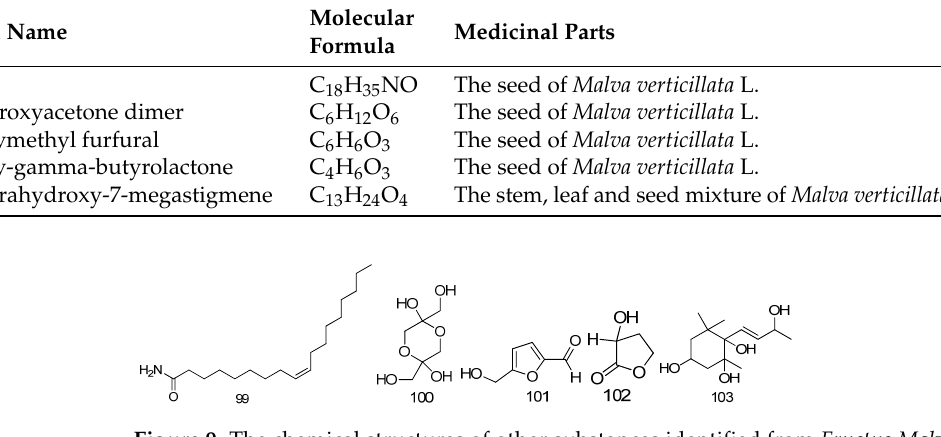
Figure 9. The chemical structures of other substances identified from Fructus Malvae .